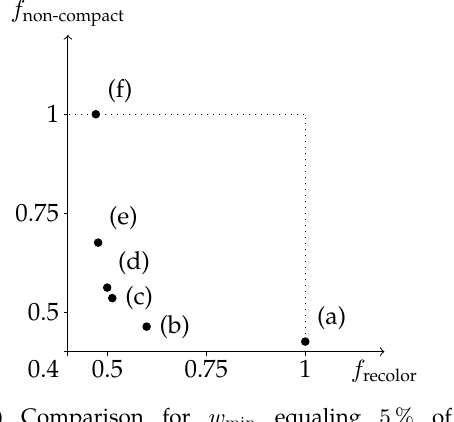
(a) Comparison for w min equaling 5 % of (b) Comparison for w min equaling 10 % of France’s total population, see Table (1) and Fig- France’s total population, see Table (2) and Fig- ure 9; absolute maximum values are 8 . 0 · 10 12 ure 10; absolute maximum values are 9 . 2 · 10 12 (non-compactness) and 6 . 4 · 10 7 (recoloring). (non-compactness) and 8 . 4 · 10 7 (recoloring). Figure 11: Costs for non-compactness and recoloring as a percentage of the maximum occurring cost; as 100 % of costs for non-compactness we take those arising while minimizing the cost for recoloring (i.e., α = 0 ) and vice